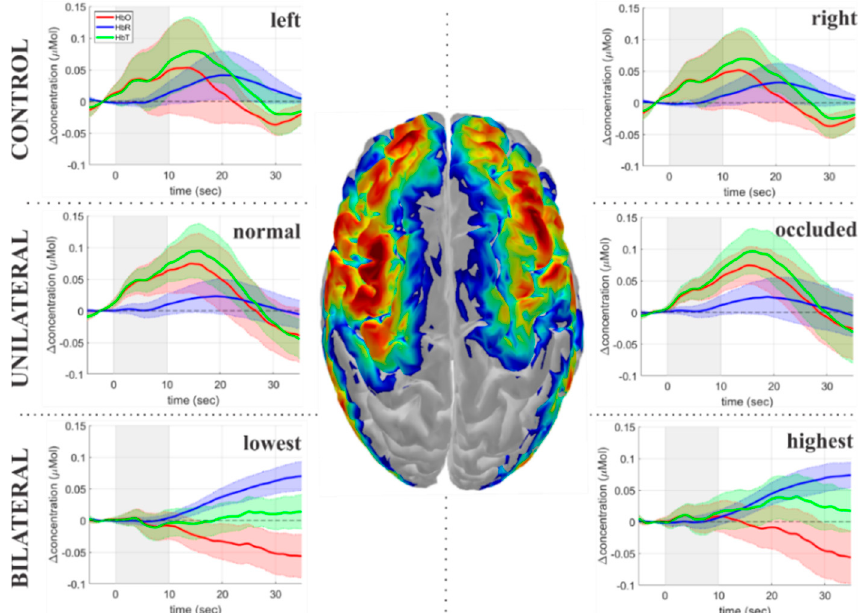
Figure 4. Group averaged time courses for each hemisphere due to the breath − holding task. The plots show the changes in oxy − hemoglobin (HbO, red), deoxy − hemoglobin (HbR, blue), and total hemoglobin (HbT, green) induced by breath − holding for each group. The left column represents the left hemisphere (controls) or the hemisphere ipsilateral to either the nonoccluded ICA (unilateral patients) or the ICA with the lowest level of occlusion (bilateral patients). The right column shows the data from the right hemisphere (controls) or the hemisphere ipsilateral to either the stenotic/occluded ICA (unilateral patients) or the ICA with the highest level of occlusion (bilateral patients). The solid curves represent the median values across subjects, while the color shadows represent the standard error of the mean. The gray shadow in the plots represents the task duration.